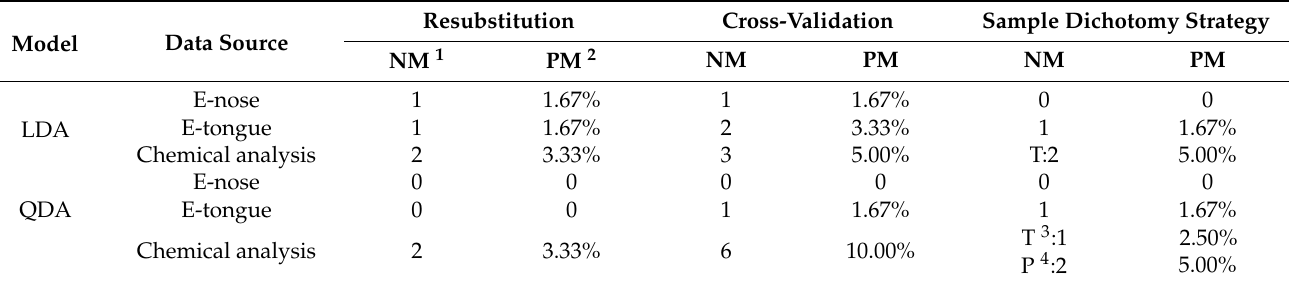
Table 2. Comparison results of LDA and QDA based on e-nose, e-tongue, and chemical analysis using different validation